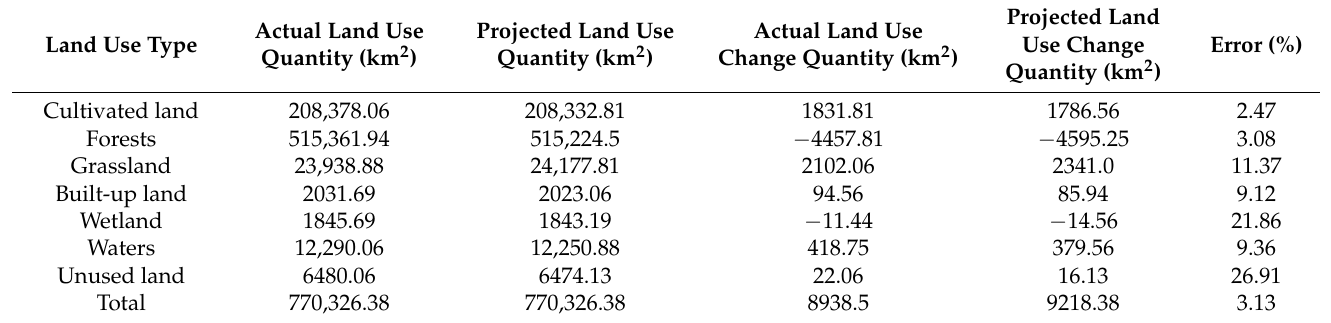
Table 3. Accuracy of the simulated land use structure in Myanmar in